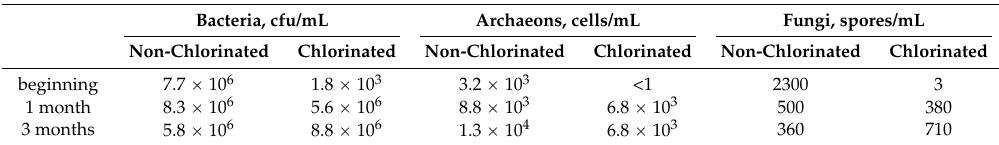
Table 1. Microbial numbers in sea water, as determined by quantitative PCR, using Escherichia coli , Halobacterium salinarum and Aspergillus versicolor as external